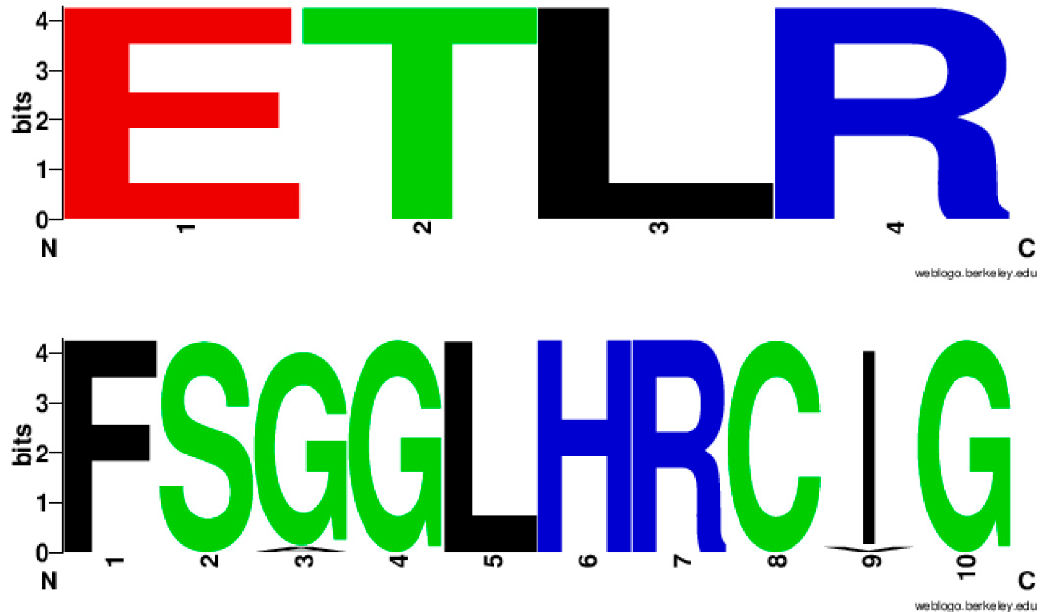
Figure 3. Analysis of amino acid patterns at the EXXR and CXG motif in CYP139 P450 family. In total 894 CYP139 P450 sequences were analysed for EXXR and CXG signature sequences.